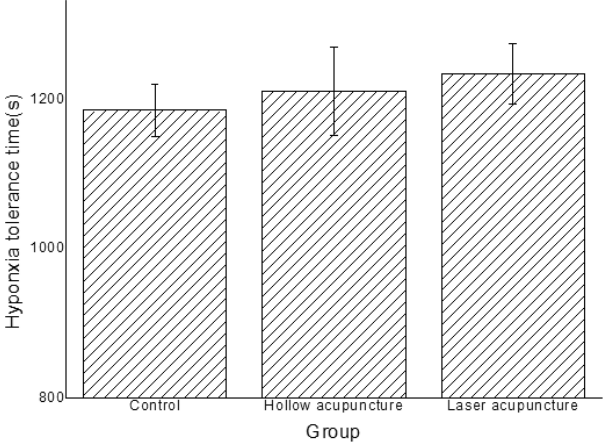
Fig. 5. Through the analysis of experimental data, we found that the mean tolerance to hypoxia in each group was as fol- lows: Control group's average resistance hypoxia time is 1185.67 s; Hollow group's average resistance hypoxia time is 1211.5 s; Laser group's average resistance hypoxia time is 1234.83 s. This shows that laser acupuncture is helpful to pro- long the hypoxia tolerance time of mice. The values presented are mean (cid:2) S.E.M. Data were analyzed using ANOVA and multiple comparison. There was no signi¯cant di®erence be- tween Control group and Hollow group ( p ¼ 0 : 714 > 0 : 05),be- tween Control group and Laser group ( p ¼ 0 : 377 > 0 : 05), and between Hollow group and Laser group ( p ¼ 0 : 948 > 0 :